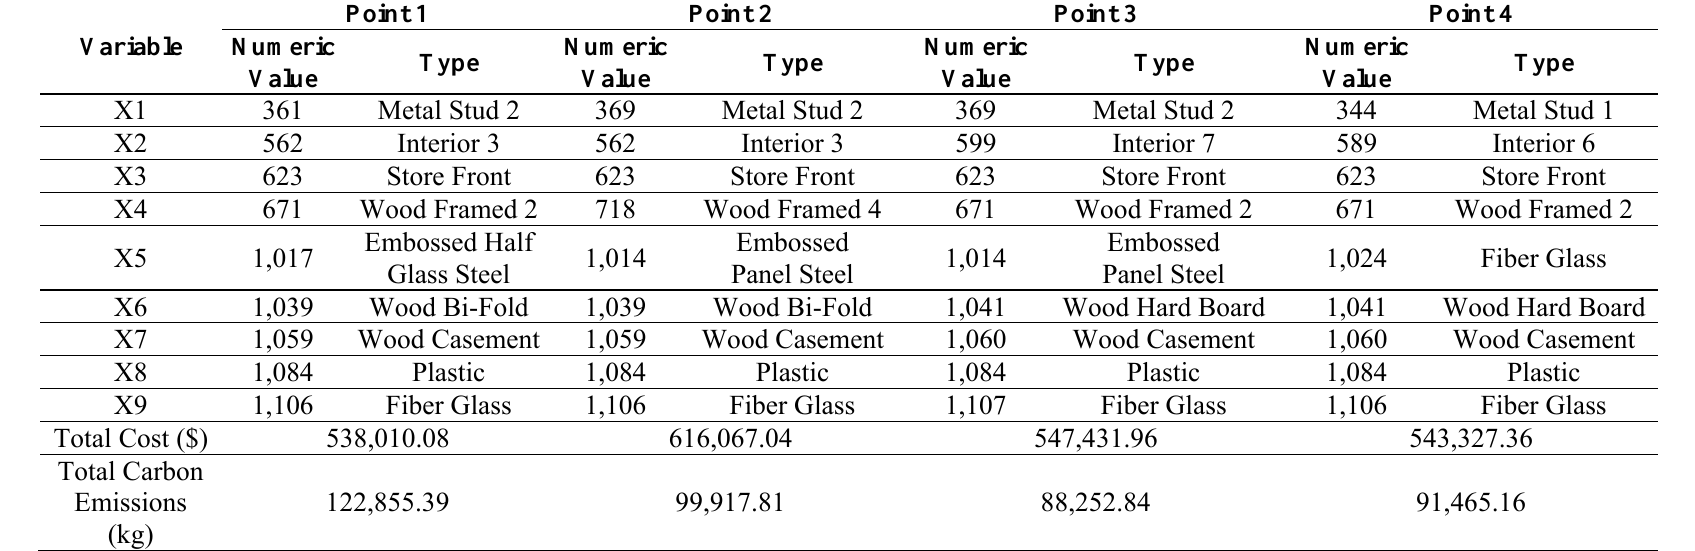
Table 9. Optimal Solutions based on Scenario